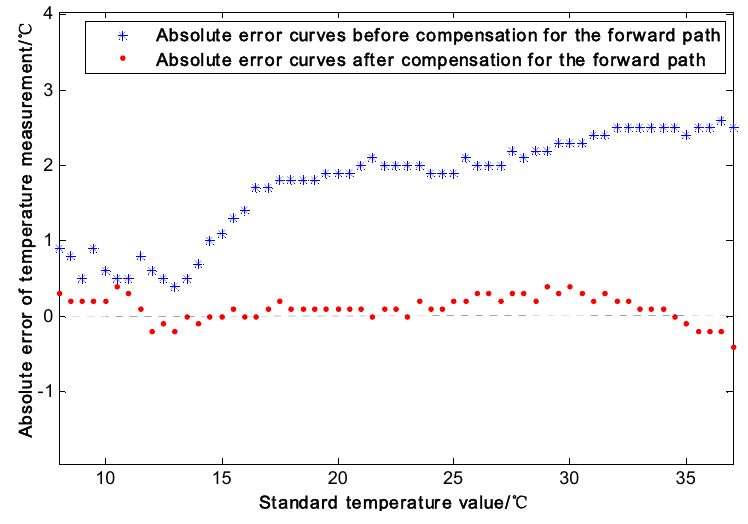
Figure 2. Absolute error curves before and after compensation for the forward